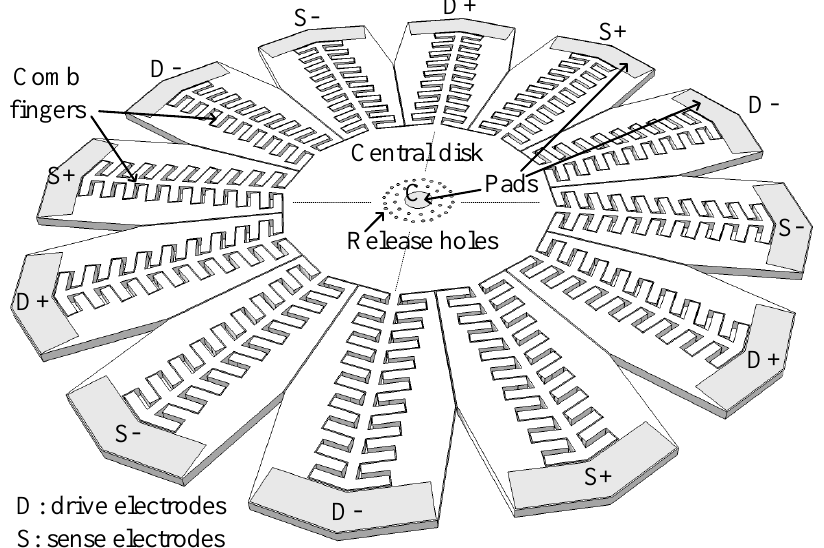
Figure 6. Schematic of the proposed gyro design (for clarity, not all the release holes are